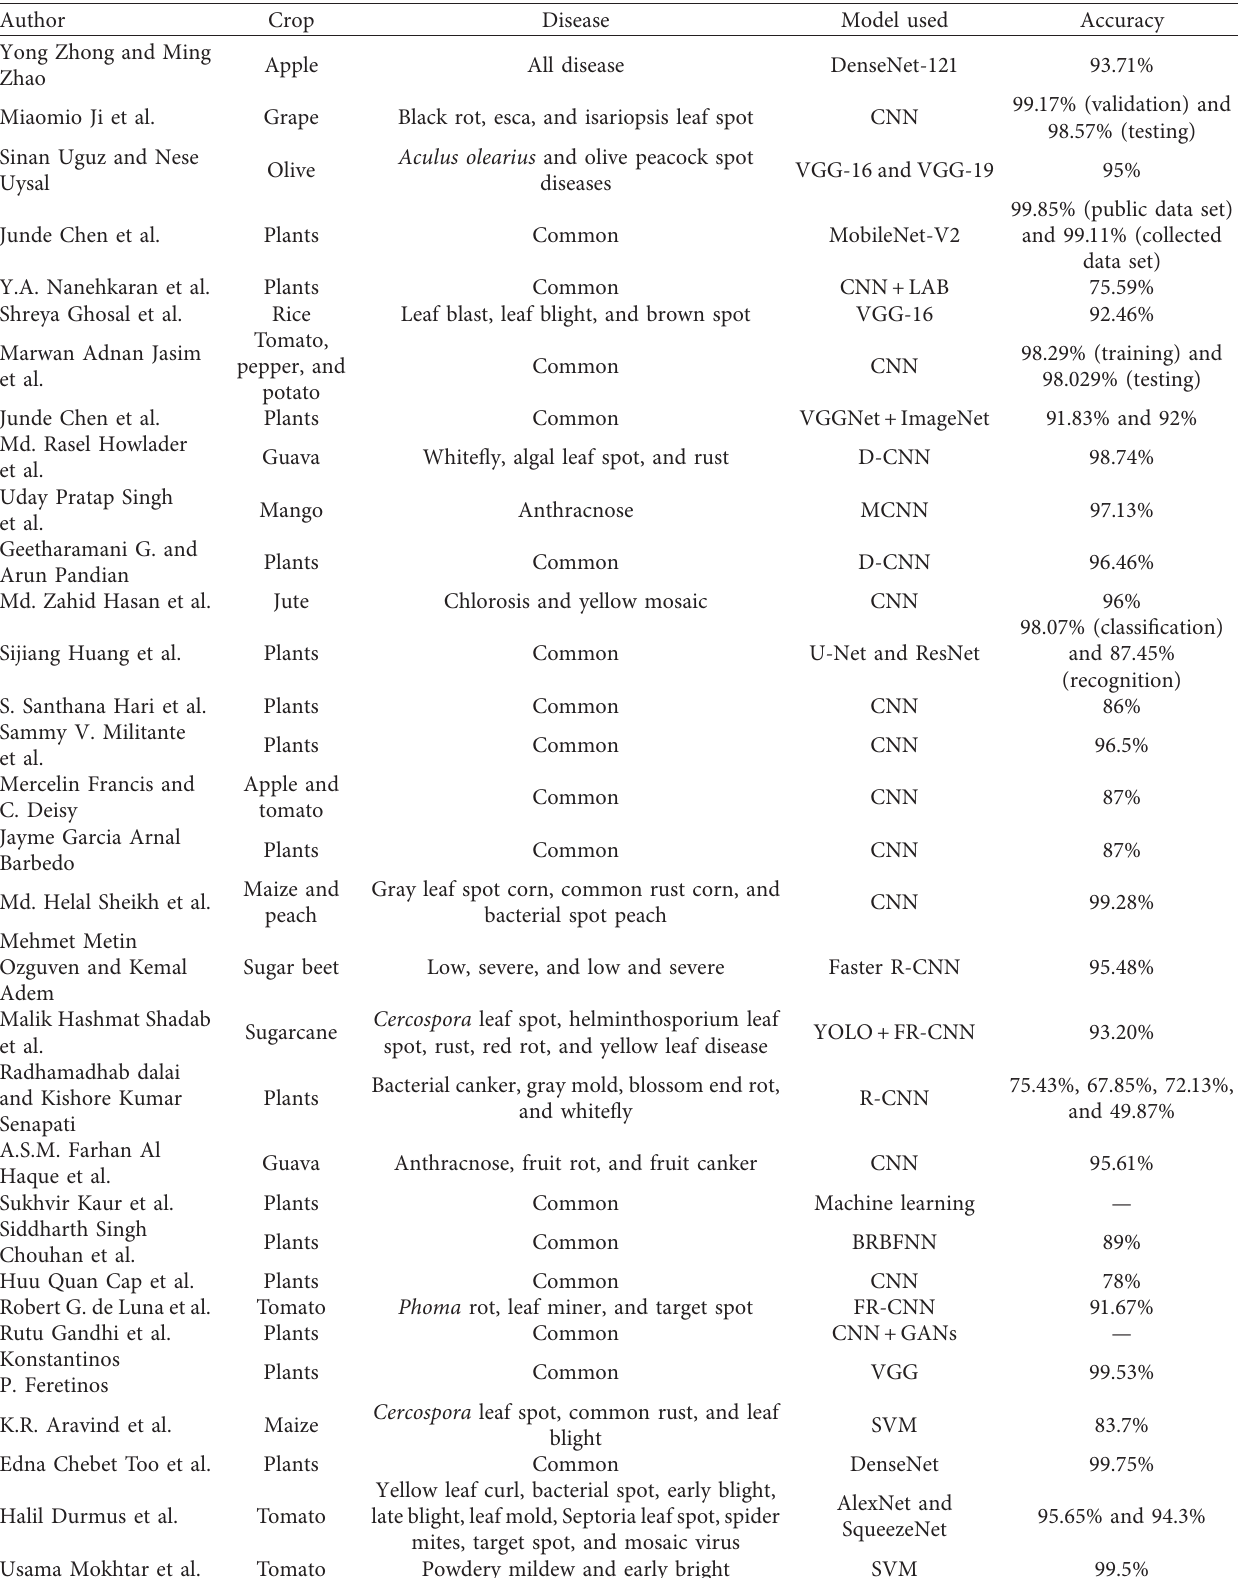
Table 1: Summary of various crops, their diseases, and the referred models and their